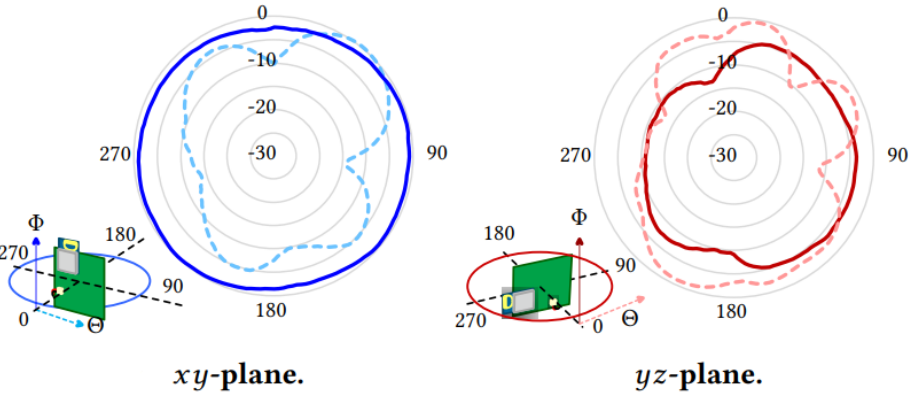
Figure 6. Radiation pattern of DWM1001 antennae in the horizontal ( x - y ) and vertical ( y - z ) planes with respect to the long axis of the tag’s enclosure